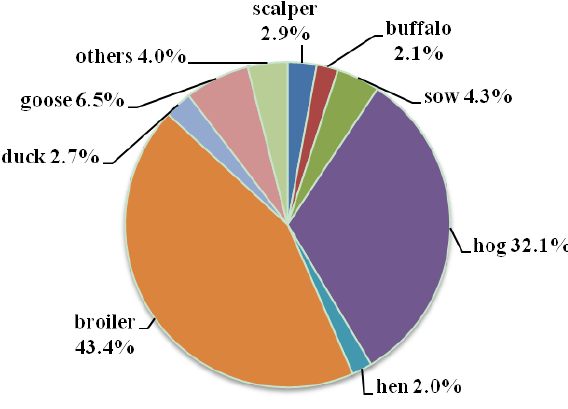
Fig. 4. Emission contributions by subcategories of livestock, 2006. are larger yields and better developments in the PRD